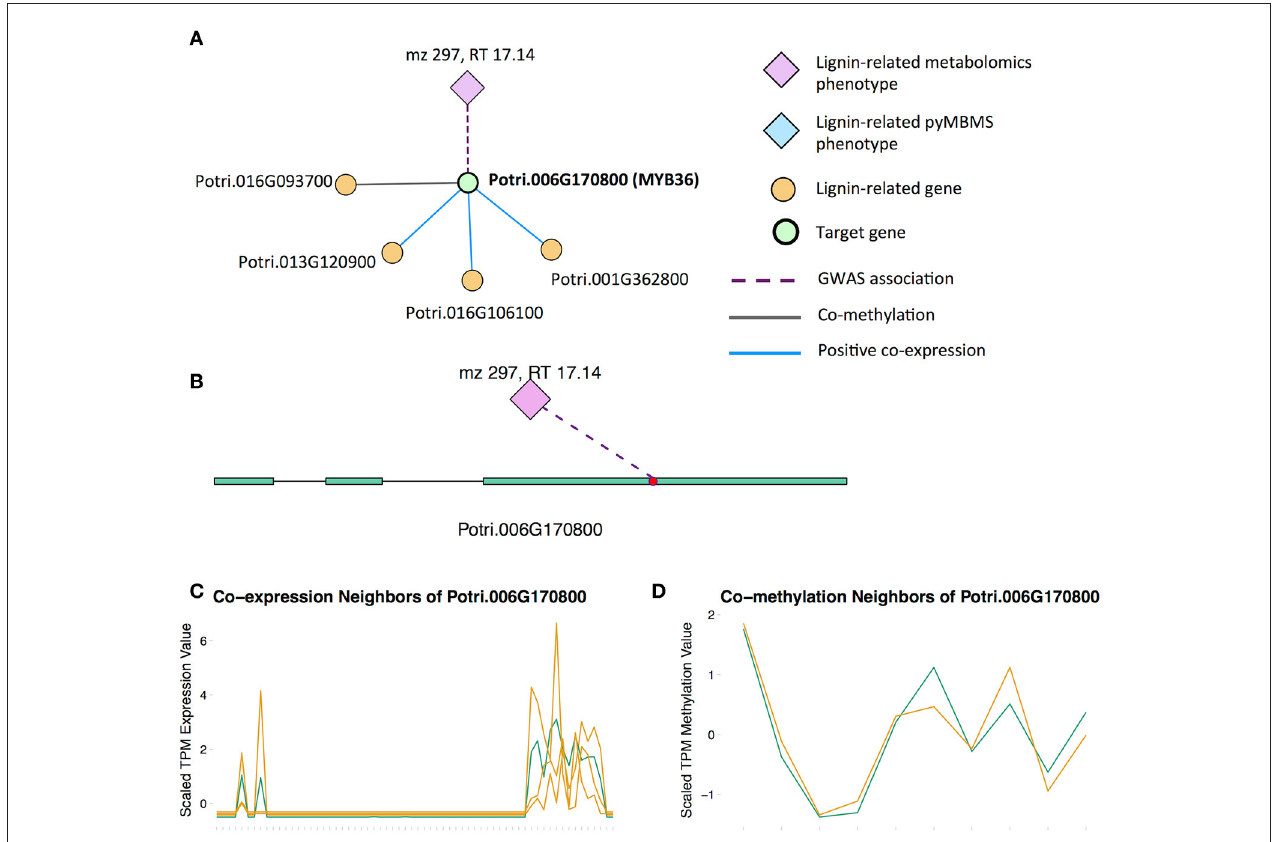
FIGURE 6 | (A) Lines of evidence for Potri.006G170800 (homolog of Arabidopsis MYB36). (B) GWAS associations of Potri.006G170800 with a lignin-related metabolite ( Table 1 ). (C) Co-expression of Potri.006G170800 with three lignin-related genes ( Table 2 ). (D) Co-methylation of Potri.006G170800 with a lignin-related gene ( Table 3 ). In line plots, the green lines represent potential target Potri.006G170800 and yellow lines represent lignin-related genes.